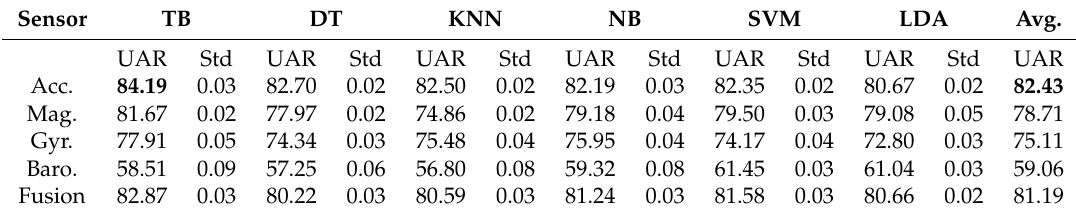
Table 6. Super-bagging results for the dominant hand: Unweighted Average Recall (UAR) in % along with the